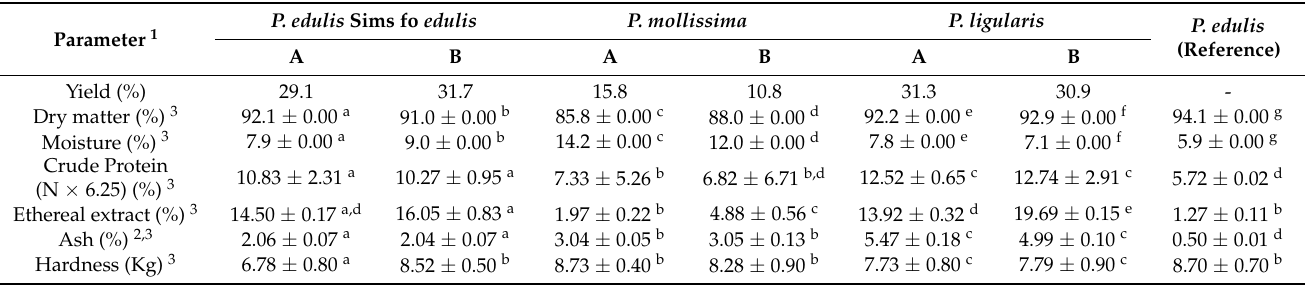
Table 2. Yield and physicochemical characterization of Passiflora ground